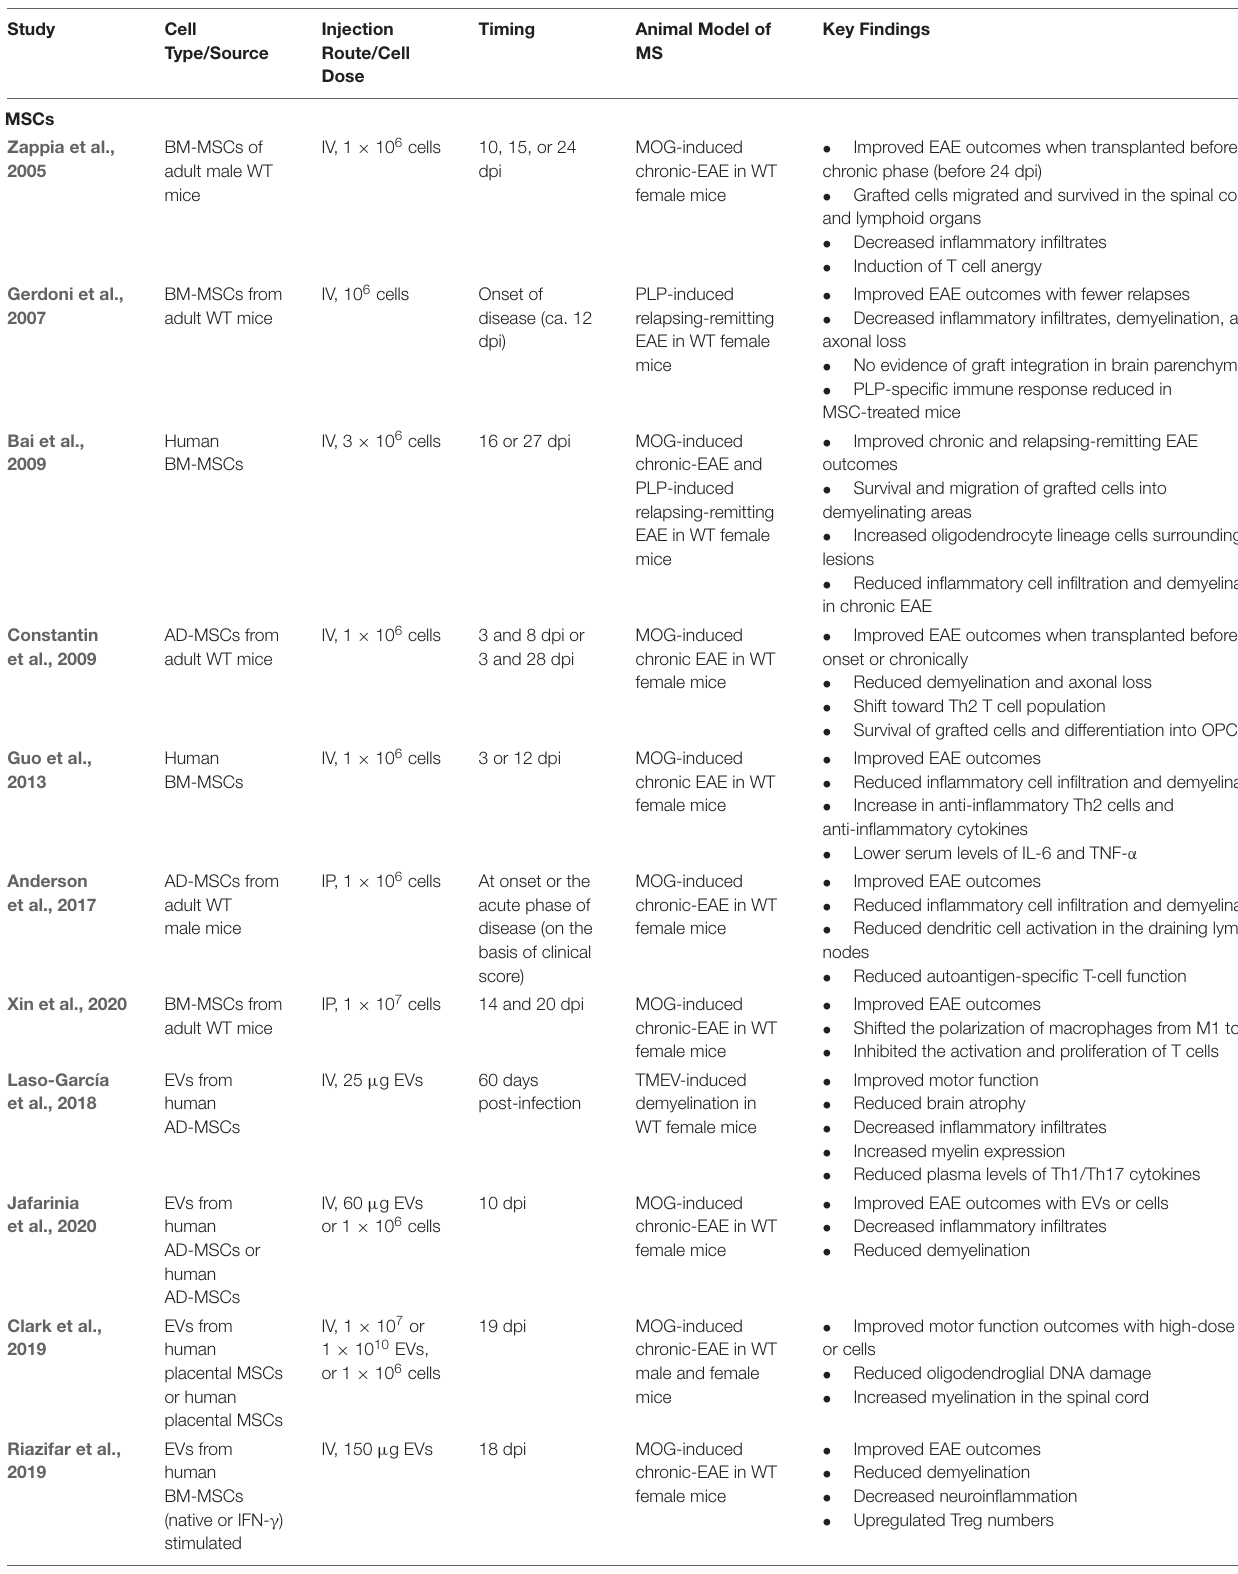
TABLE 1 | Preclinical evidence of non-hematopoietic stem cells in treating